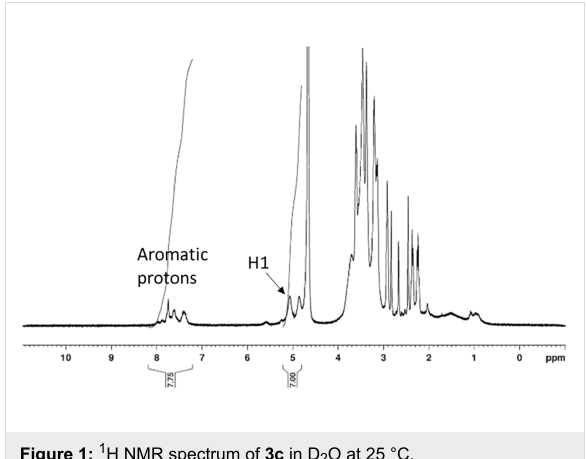
Figure 1: 1 H NMR spectrum of 3c in D 2 O at 25